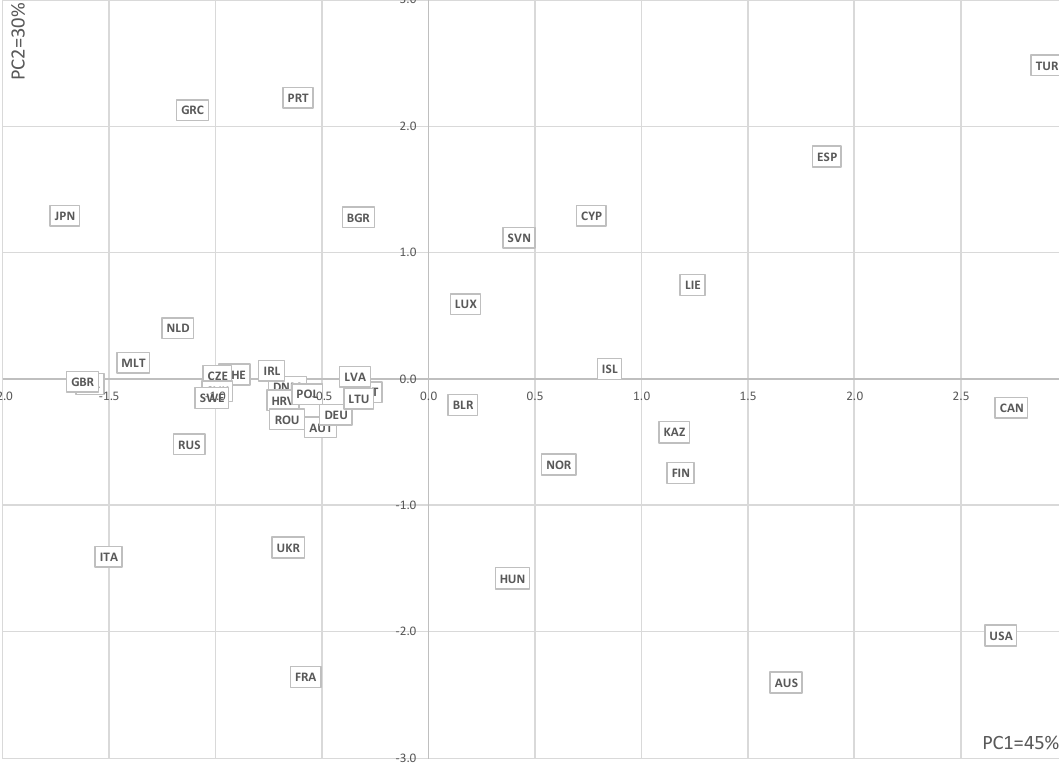
Figure 7. The representation of the trends in the Annex I countries emissions from four main agricultural sources in the coordinate system created by the first and second principal components (PC1 and PC2).